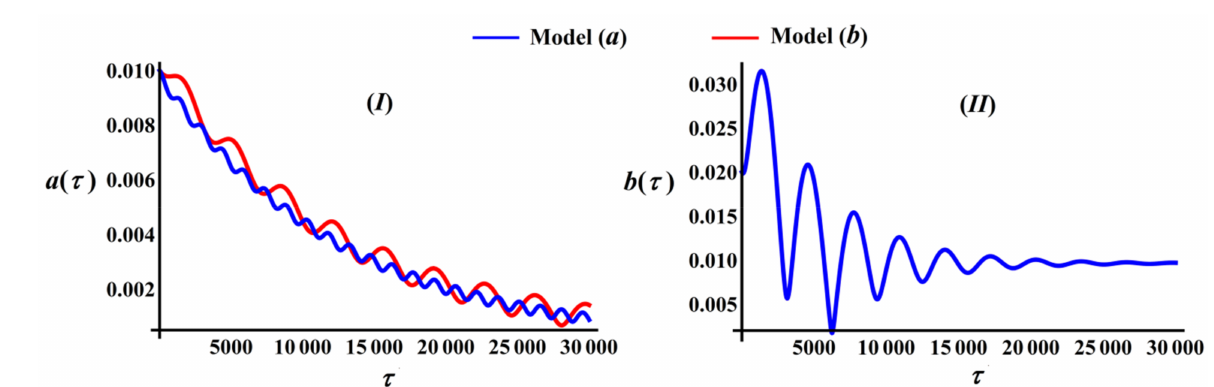
Figure 2. The variation of: ( I ) a with time τ and ( II ) b with time τ .